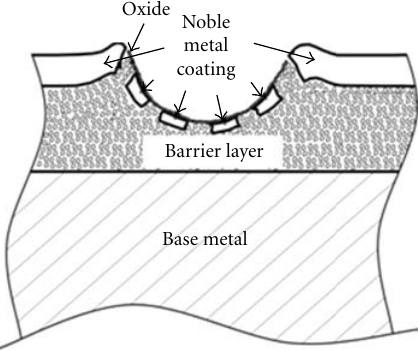
Figure 21: Wear pattern III partial wearing o ff of the upper layer and contact surface totally covered with oxide.